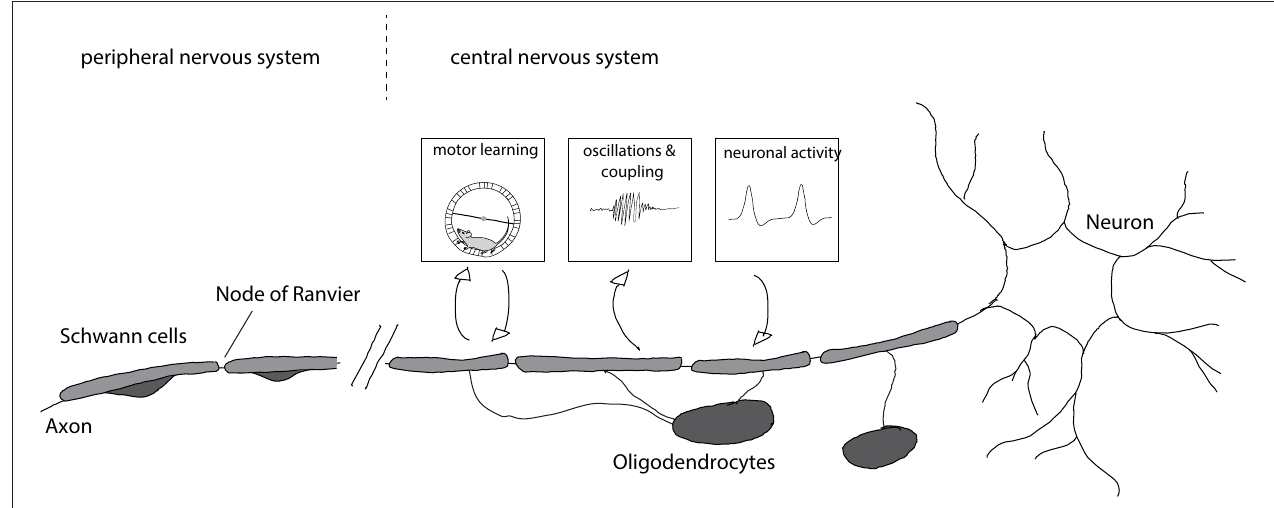
FIGURE 1 | Myelination of axons and consequences for circuit function. Axons in the central nervous system are myelinated by oligodendrocytes whereas axons in the peripheral nervous system are myelinated by Schwann cells. Myelination is enhanced after motor learning and the newly formed myelin is necessary for learning. Furthermore, newly formed myelin is implicated in increased coupling between cortical spindle oscillations and hippocampal sharp wave ripples that affect memory formation. Enhanced neuronal activity after chemogenetic or optogenetic stimulation results in increased myelin formation and thicker myelin